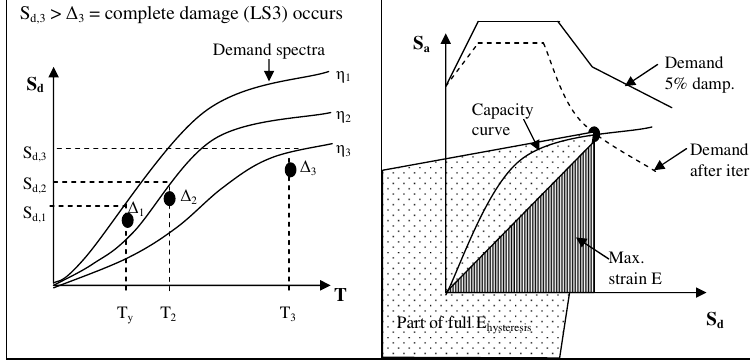
Fig. 3. Displacement-Based vs. Capacity Spectrum Method. Figure 3. Displacement-based vs. Capacity Spectrum Method 3